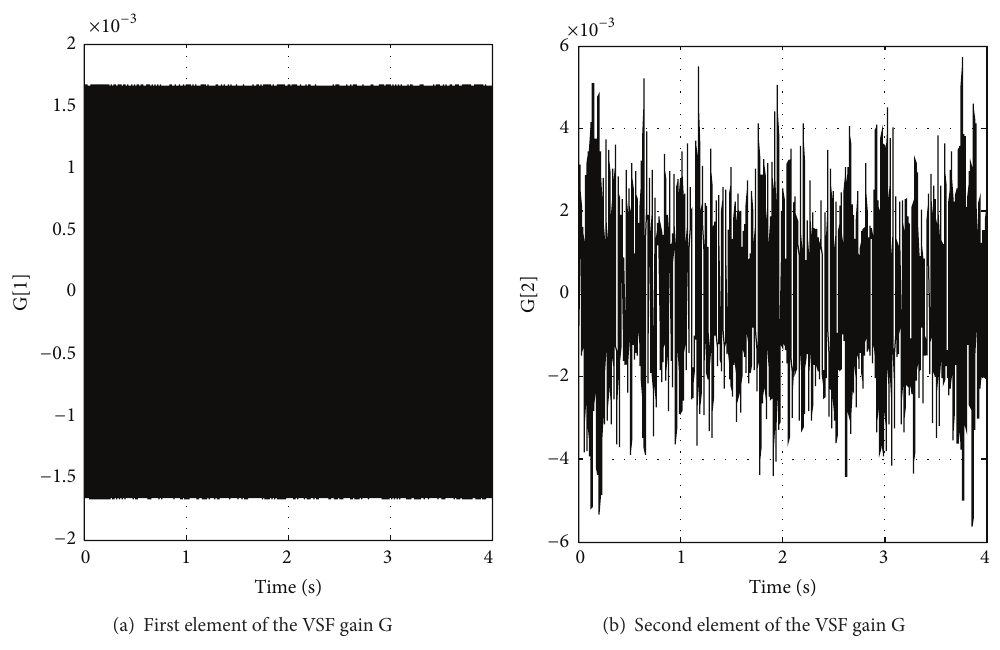
Figure 6: Chattering behavior of the elements of the VSF